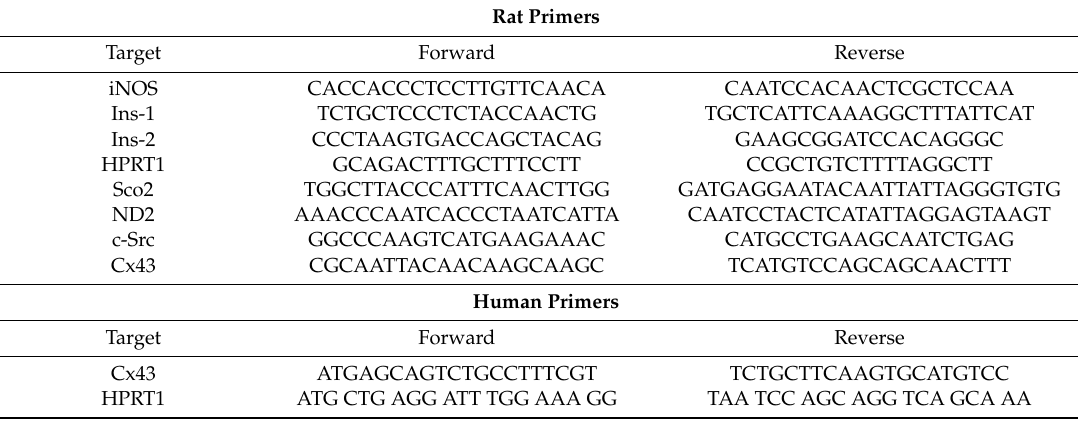
Table 2. Rat primer